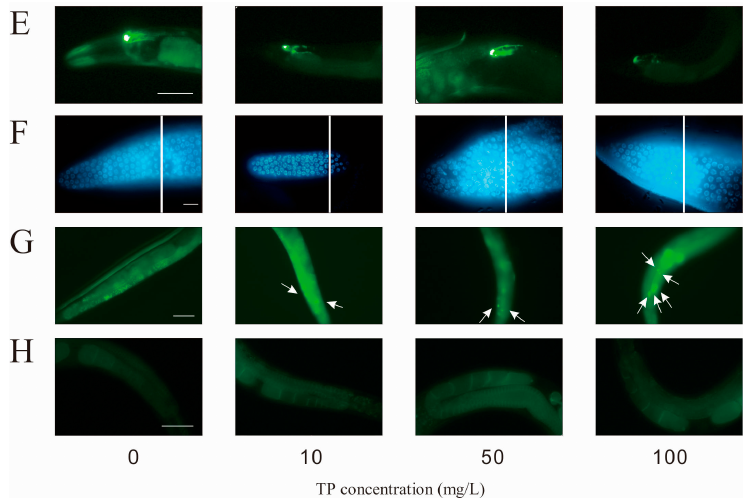
Figure 8. Effects of exposure to TP for 4 h on the oocytes at different developmental stages: ( A ) comparison of the effects of TP on the area of DTCs after 24, 48, and 72 h of exposure; ( B ) comparison of the effects of TP on the number of mitotic germ cells per gonad arm of nematodes after 24, 48, and 72 h of exposure; ( C ) comparison of effects of TP on the number of apoptotic cells per gonad arm of nematodes after 24, 48, and 72 h of exposure; ( D ) comparison of effects of TP on the number of oocytes in diakinesis per gonad arm of nematodes after 24, 48, and 72 h of exposure; ( E ) effects of TP on the morphology of DTCs after 24 h of exposure (scale bar, 50 µm); ( F ) effects of TP on mitotic germ cells after 24 h of exposure, where the left area beside the white line contains mitotic cells (scale bar, 10 µm); ( G ) effects of TP on apoptosis after 24 h of exposure, where the arrow indicates apoptotic cells (scale bar, 50 µm); and ( H ) effects of TP on oocytes in diakinesis after 24 h of exposure (scale bar, 50 µm). TP, Triptolide. Bars represent means ± SEM. * p < 0.05 vs. the control group.